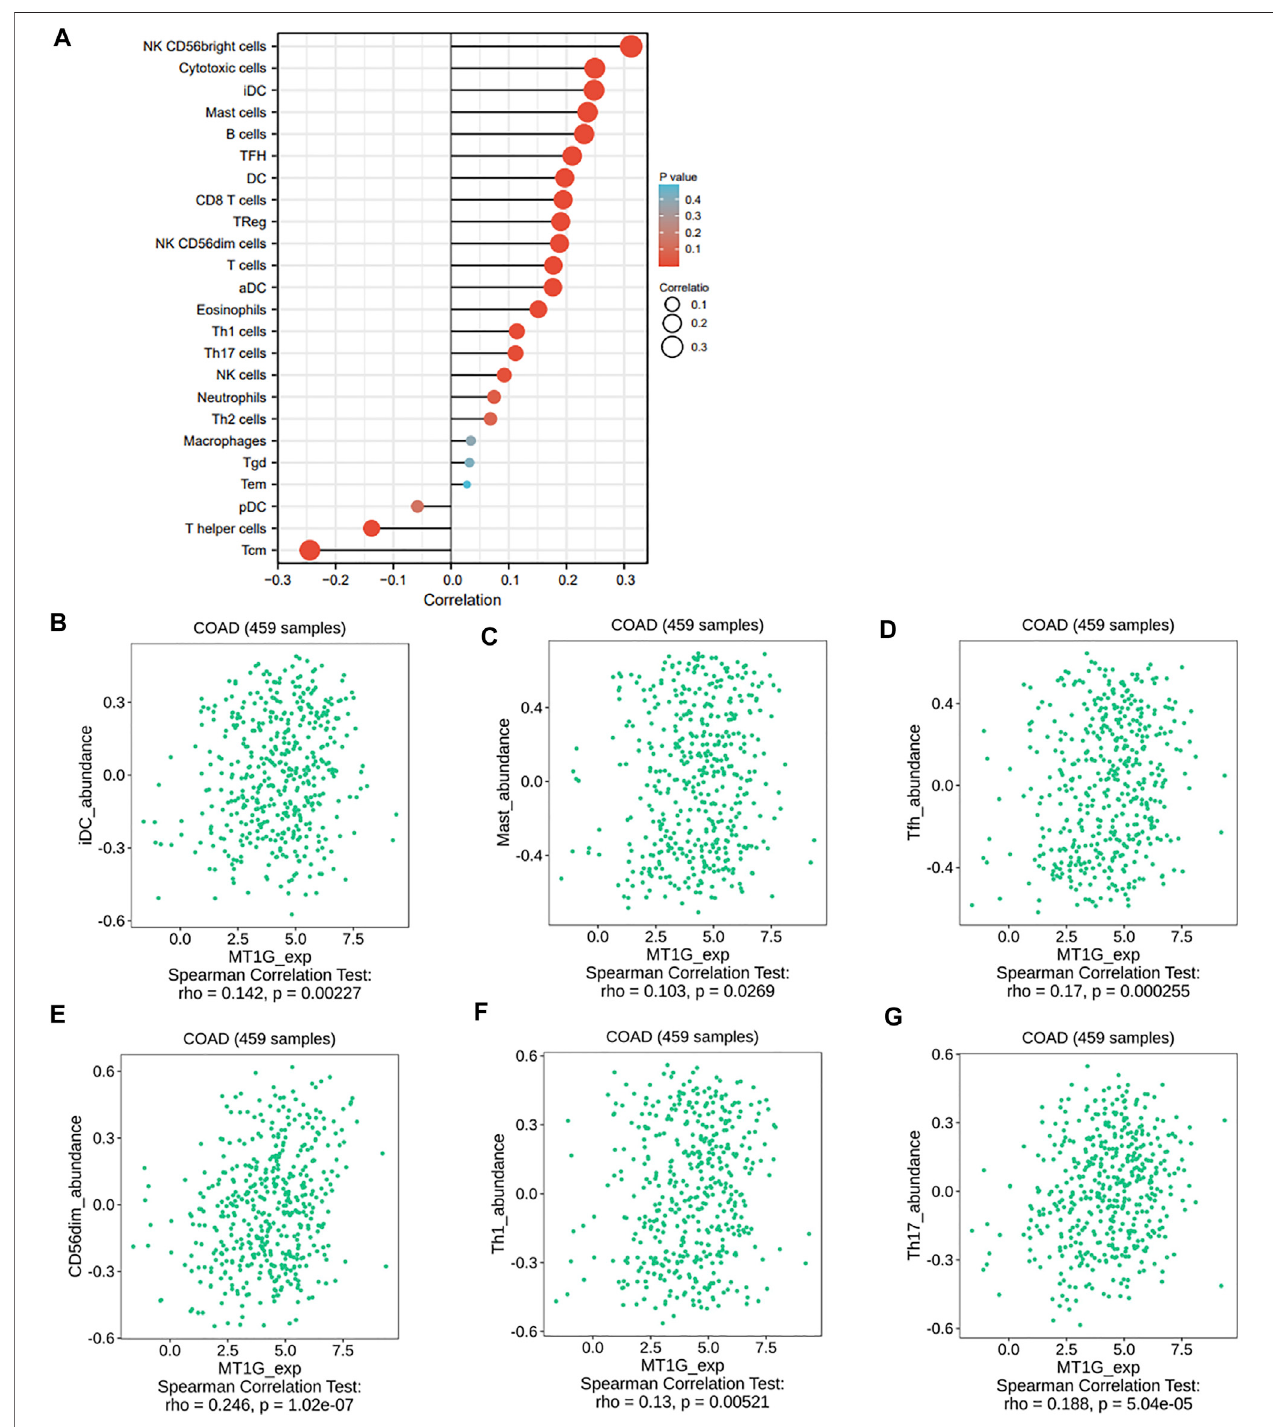
FIGURE 6| Relationship ofimmunein fi ltration cells and the MT1G expression. (A) Correlations between a variety ofimmunein fi ltration cells and MT1G expression though the ssGESA algorithm. (B – G) Associations between MT1G with several immune cells, such as iDCs, mast cells, NK CD56dim cells, Th1 cells, and Th17 cells, were further validated by the TISIDB database.